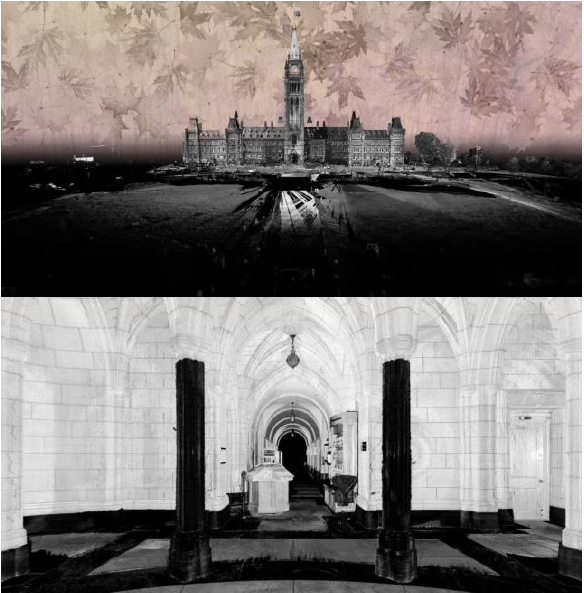
Figure 1. Screenshots from the introductory point cloud animation of the Senate Virtual Tour made with Pointools